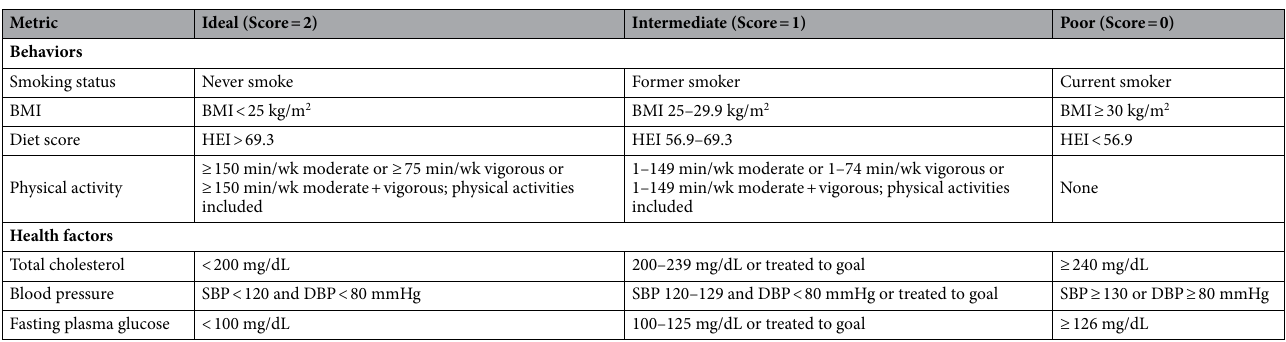
Table 1. Definitions of cardiovascular health metrics. BMI body mass index, HEI healthy eating index, SBP systolic blood pressure, DBP diastolic blood